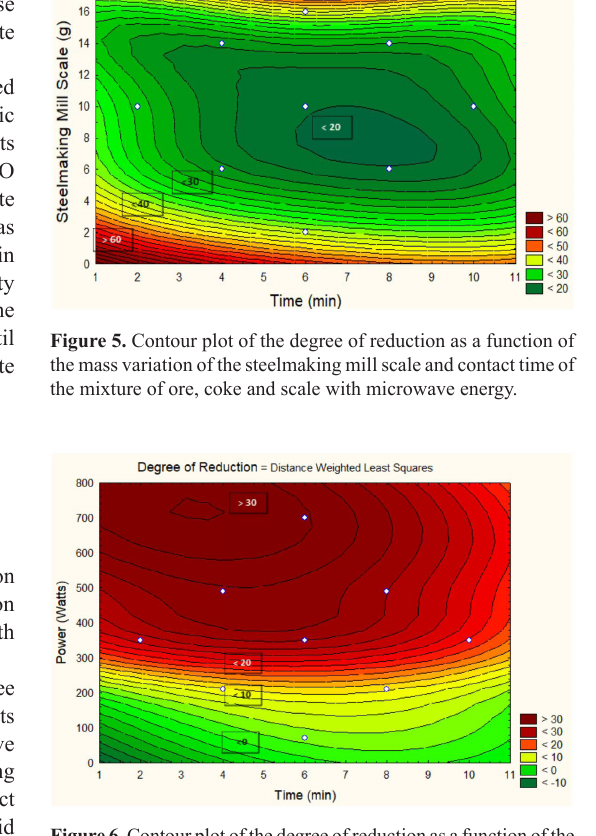
Figure 6. Contour plot of the degree of reduction as a function of the variation of the applied power and the contact time of the mixture of ore, coke and scale with microwave